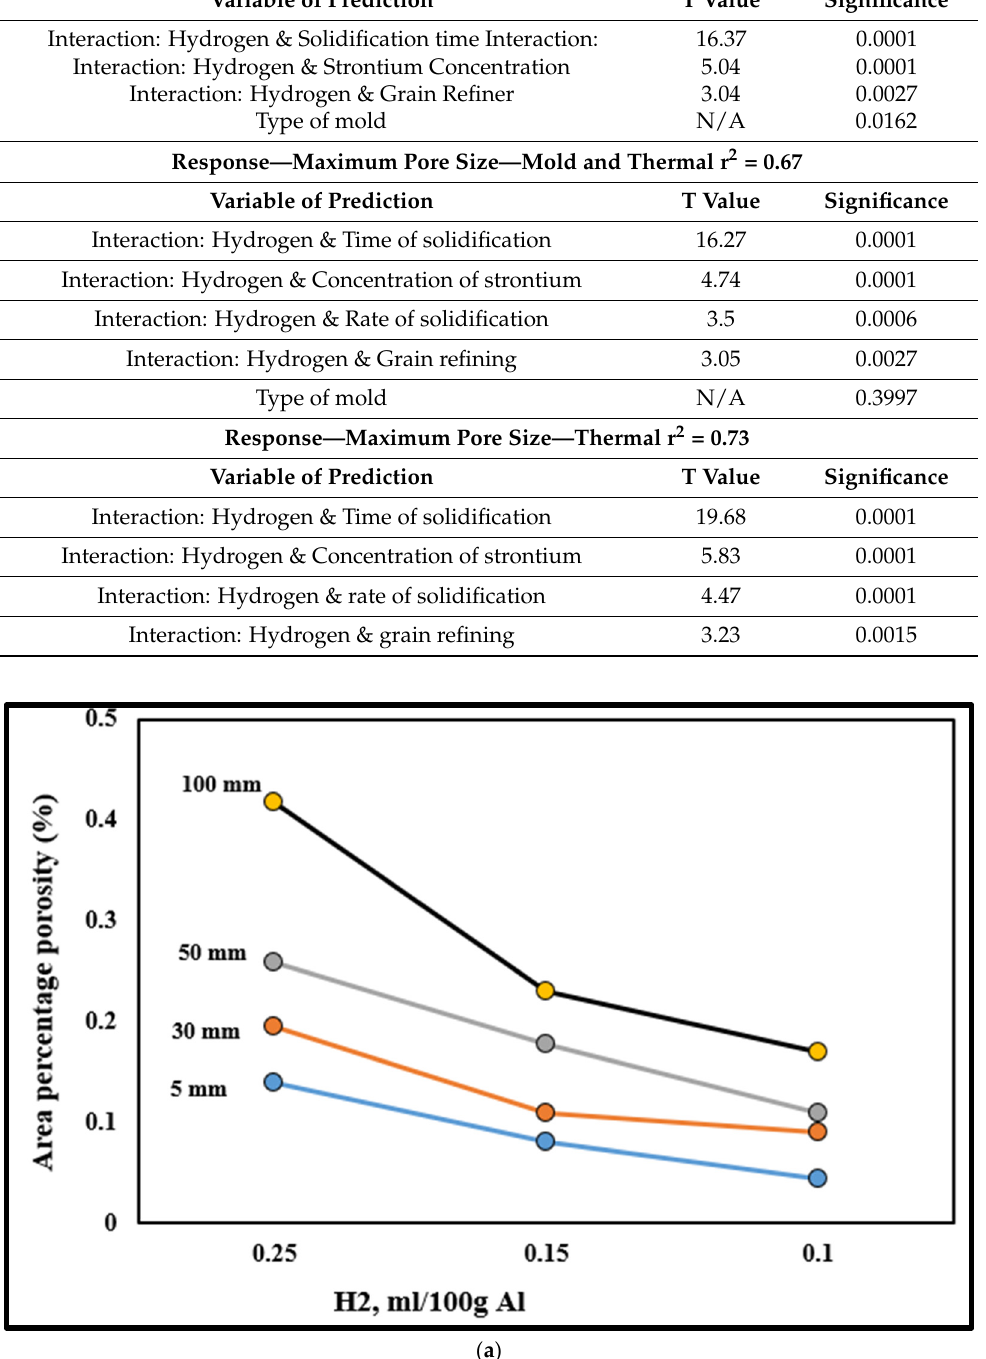
( b ) Figure 16. Variation in ( a ) porosity percentage and ( b ) density of porosity as a function of distance from the chill end. 4. Analysis of Statistical Data To obtain distinctive and comparative results for end chill mold, we applied the mul- tiple-regression technique independently of the type of mold. The multiple-regression technique is applied to 135 cases for the directional solidification mold. The multiple-re- gression technique consists of a series of independent variables, which can be written in the form: 𝑦 (cid:3036) = 𝛽 (cid:2868) + 𝛽 (cid:2869) 𝑥 (cid:2869)(cid:3036) + 𝛽 (cid:2870) 𝑥 (cid:2870)(cid:3036) + ⋯ + 𝛽 (cid:3043) 𝑥 (cid:3043)(cid:3036) + 𝑢 (cid:3036) . 𝑖 = 1, 2, … , 𝑛